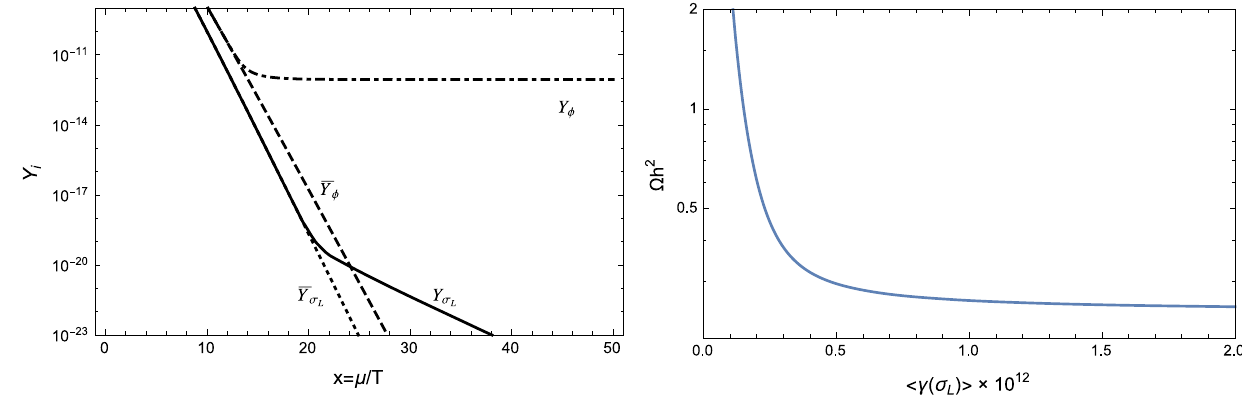
10 − 11 GeV − 2 , (cid:2) σ(φ + φ − ; SM )v (cid:3) = 10 − 11 GeV − 2 for both the left- and right-hand panels, while (cid:2) γ(σ L ) (cid:3) = 10 − 9 GeV is assumed for the = 500 GeV, m = 550 left-hand L DM